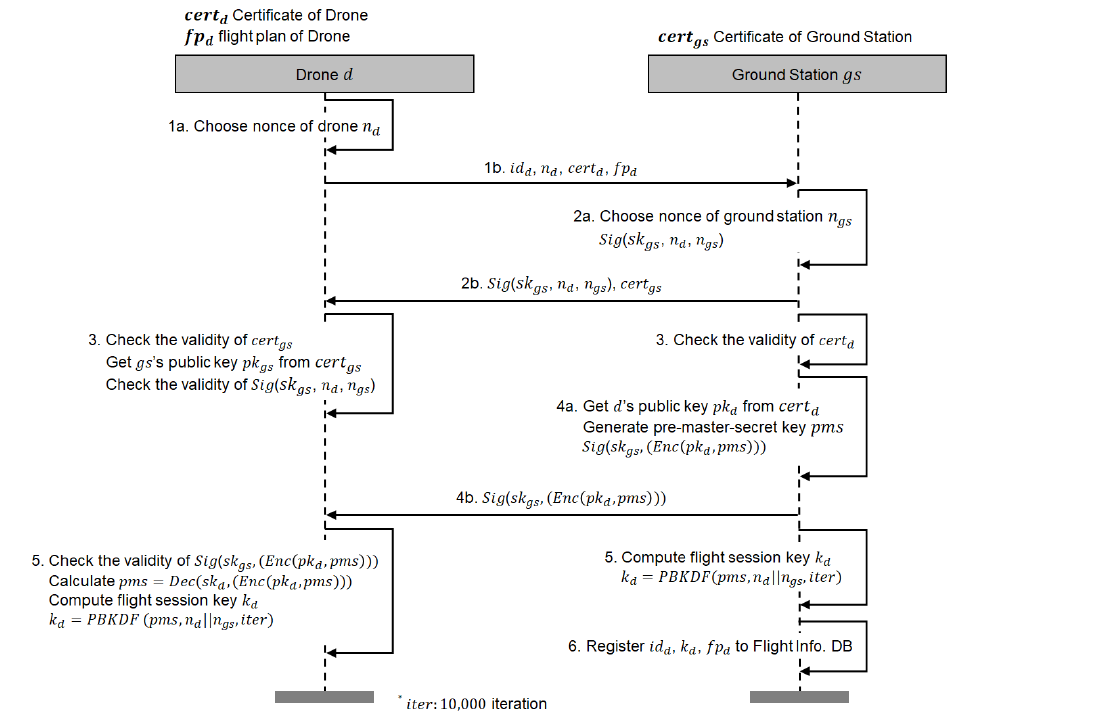
Figure 3. Mutual authentication and key agreement